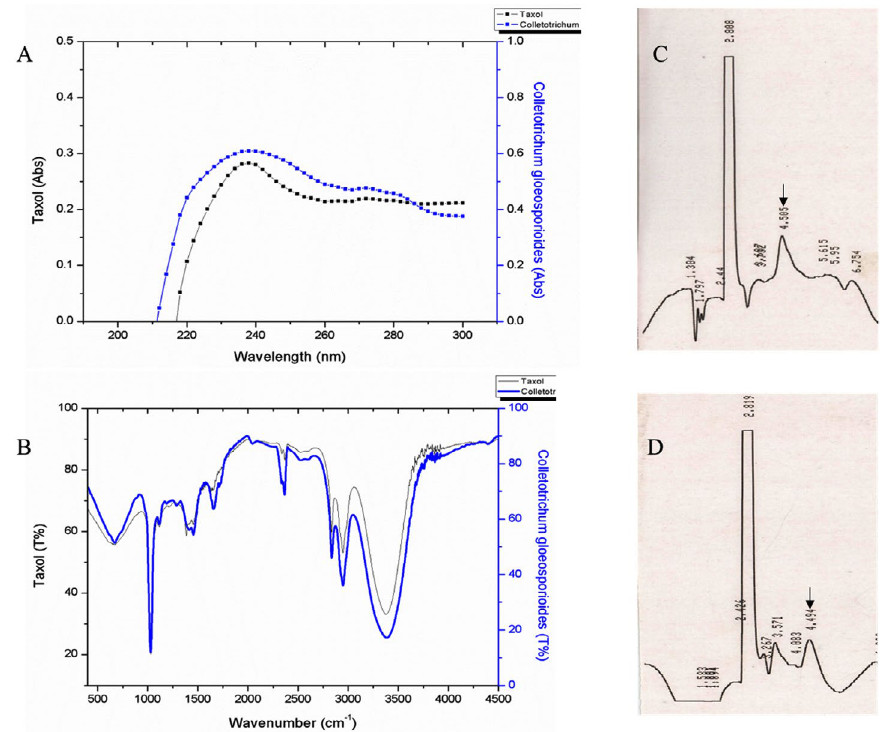
Fig. 3. Shows the data of spectral and chromatographic analysis of putative fungal taxol from Colletotrichum sp. MIP-5 and Paclitaxel. (A) UV-Visible spectrum (B) FTIR spectrum and (C & D) HPLC Chromatogram of Paclitaxel and putative fungal taxol from Colletotrichum sp.